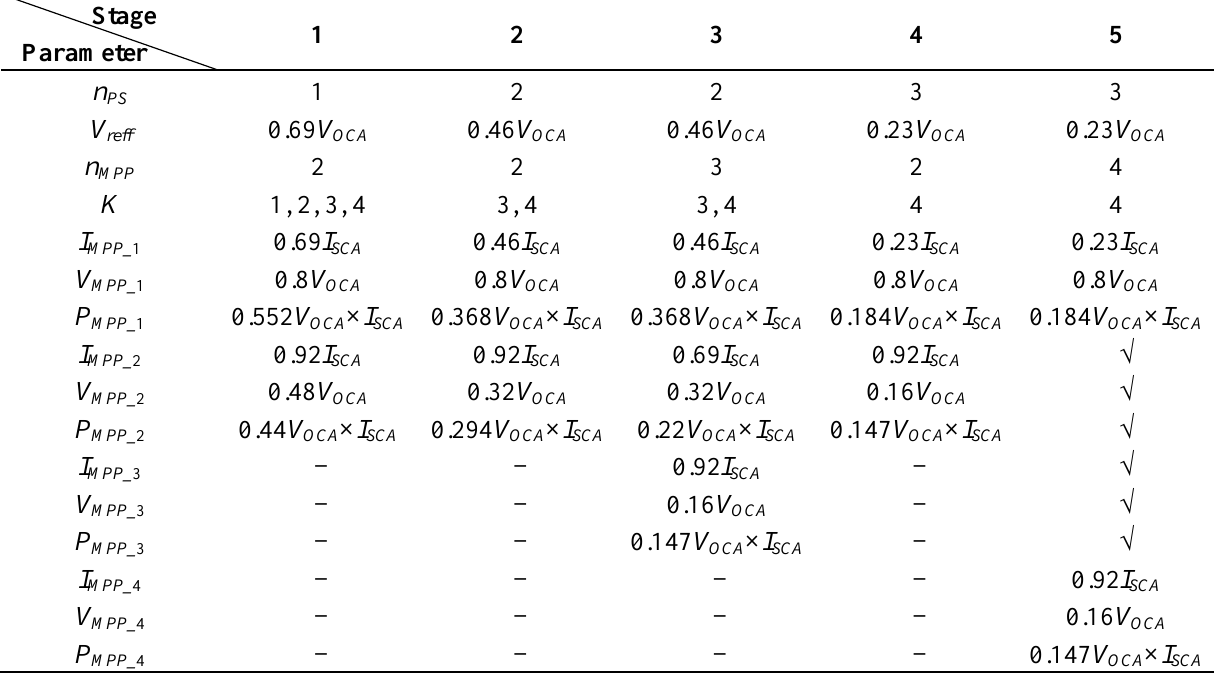
Table 1. Mathematical analysis from the results based on the linear